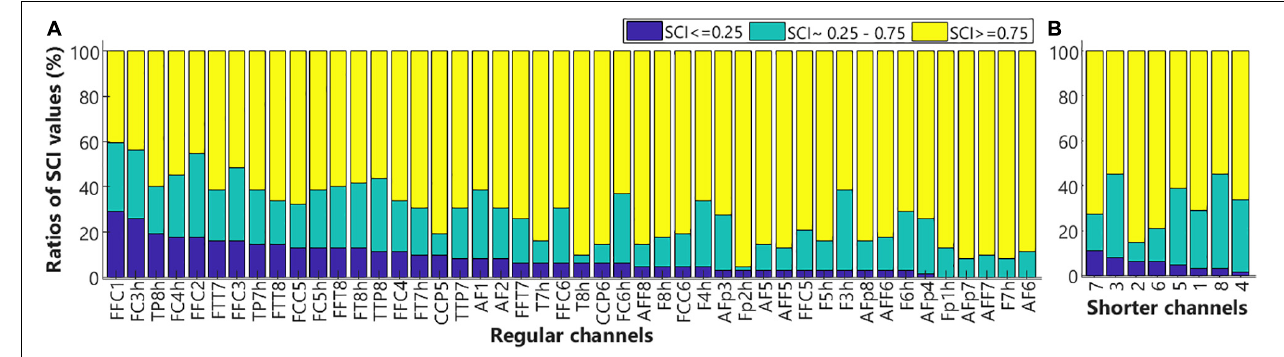
FIGURE 7 | The ratios of scalp coupling index (SCI) values. Bar plots show the ratio of SCI values below 0.25 (blue), within 0.25–0.75 (teal), and above 0.75 (yellow) for the regular (A) and shorter (B) channels. Low SCI values indicate poor signal qualities.